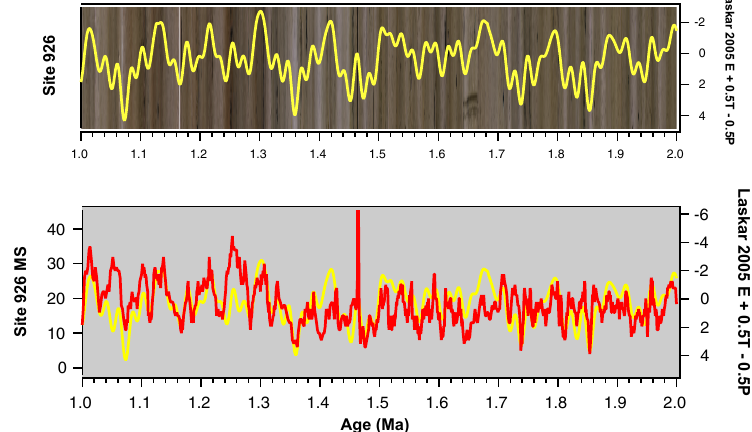
Figure 7. Laskar et al. (2004) orbital calculation compared to the Site 926 composite image and MS data. E , eccentricity; T , tilt (obliquity); and P , precession. The Laskar curve was compared to MS to check the age model used in this study that was based on the images and color reflectance. The composite image is the result of comparing multiple data sets and individual core